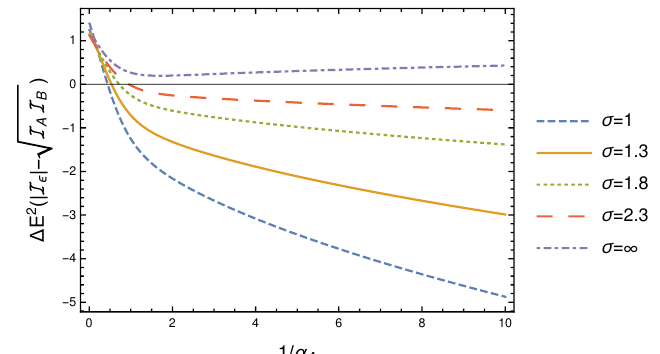
√ (cid:0) (cid:1) is plotted for two anti-parallelly |I ε | − I A I B for different fixed A = 1 . B